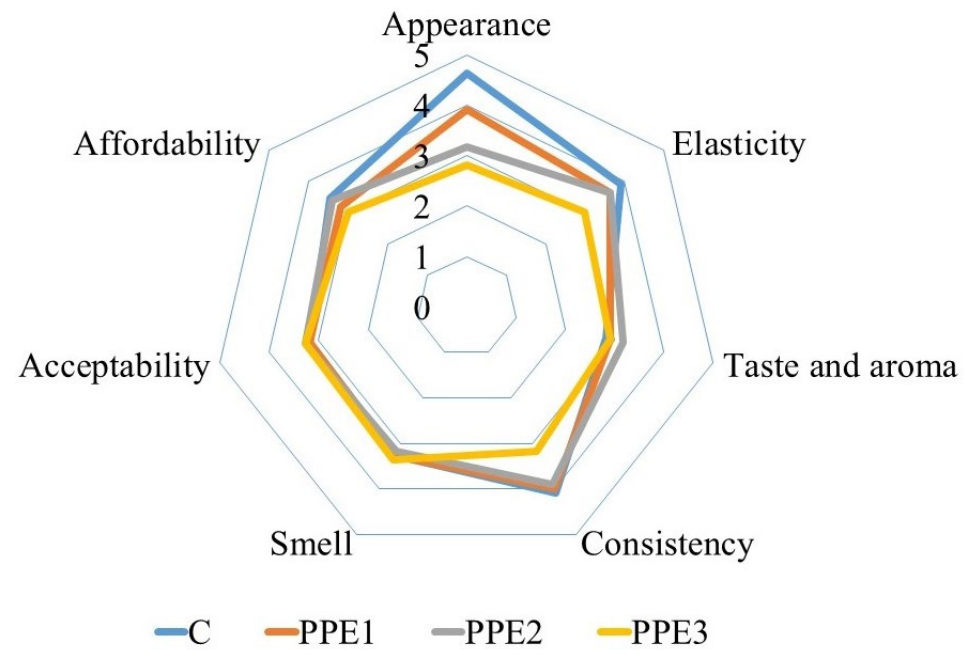
Figure 8. Sensory evaluation of “Boba balls” produced with gelatin/sodium alginate composite containing pomegranate peel extract (PPE) at various concentrations. (C: Control without PPE; PPE1: “Boba balls” containing 1% PPE; PPE2: “Boba balls” containing 2% PPE; PPE3: “Boba balls” containing 3%